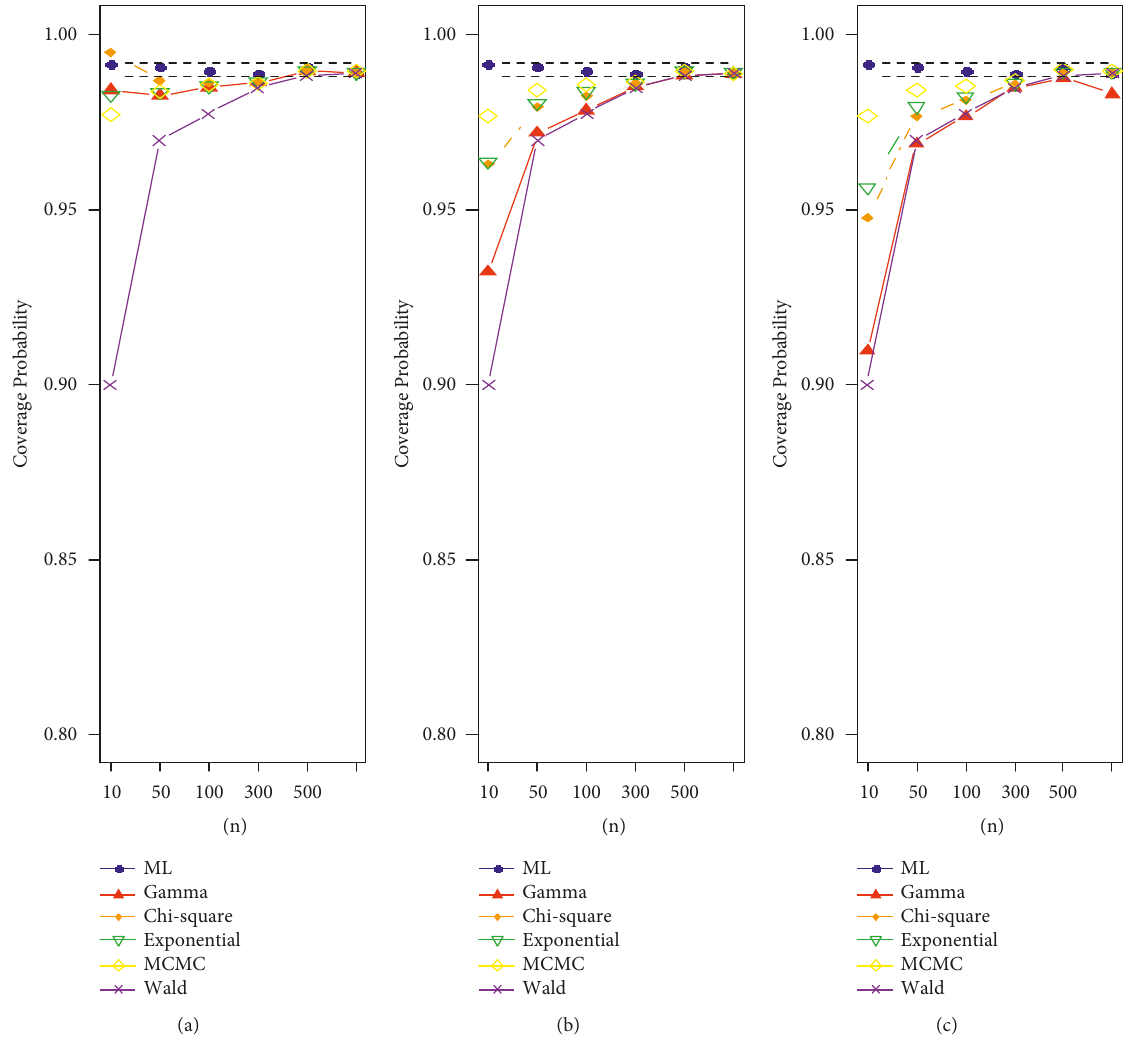
Figure 7: The trend of CP for all methods varies by the sample sizes at 99% confidence interval. (a) Variance � 2. (b) Variance � 4. (c) Variance �